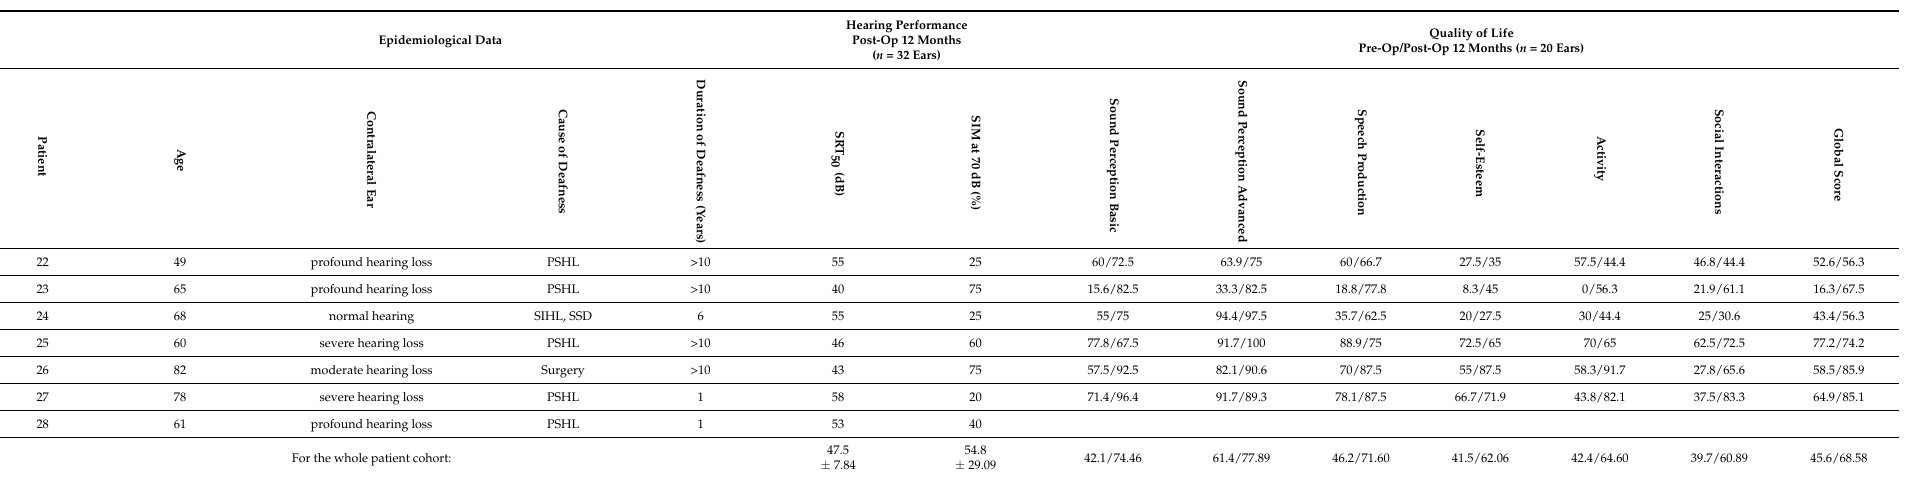
Table 2 Patient-level data with epidemiologic characteristics, functional results and quality of life scores of Nijmegen Cochlear Implant Questionnaire. SIHL: sudden idiopathic hearing loss, SSD: single-sided deafness, PSHL: progressive sensorineural hearing